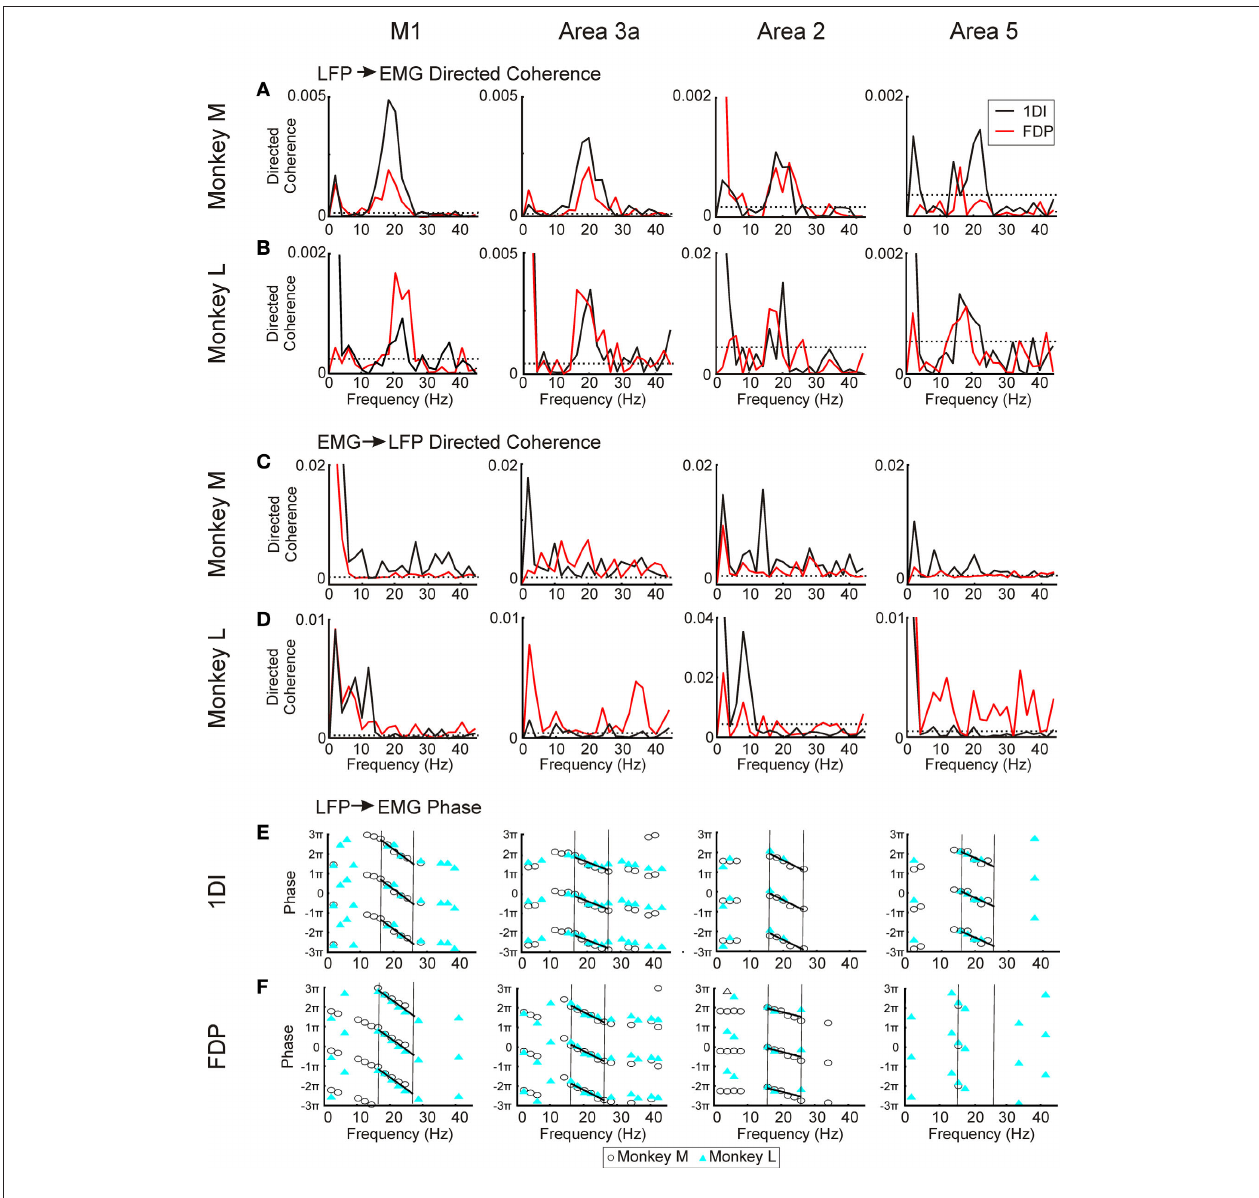
Figure 4 | LFP–eMg directed coherence. (A,B) LFP → EMG directed coherence for the four cortical areas in monkey M and L respectively. (C,D) EMG → LFP directed coherence for the four cortical areas in monkey M and L respectively. Dotted lines in (A–D) represent P < 0.05 significance levels.